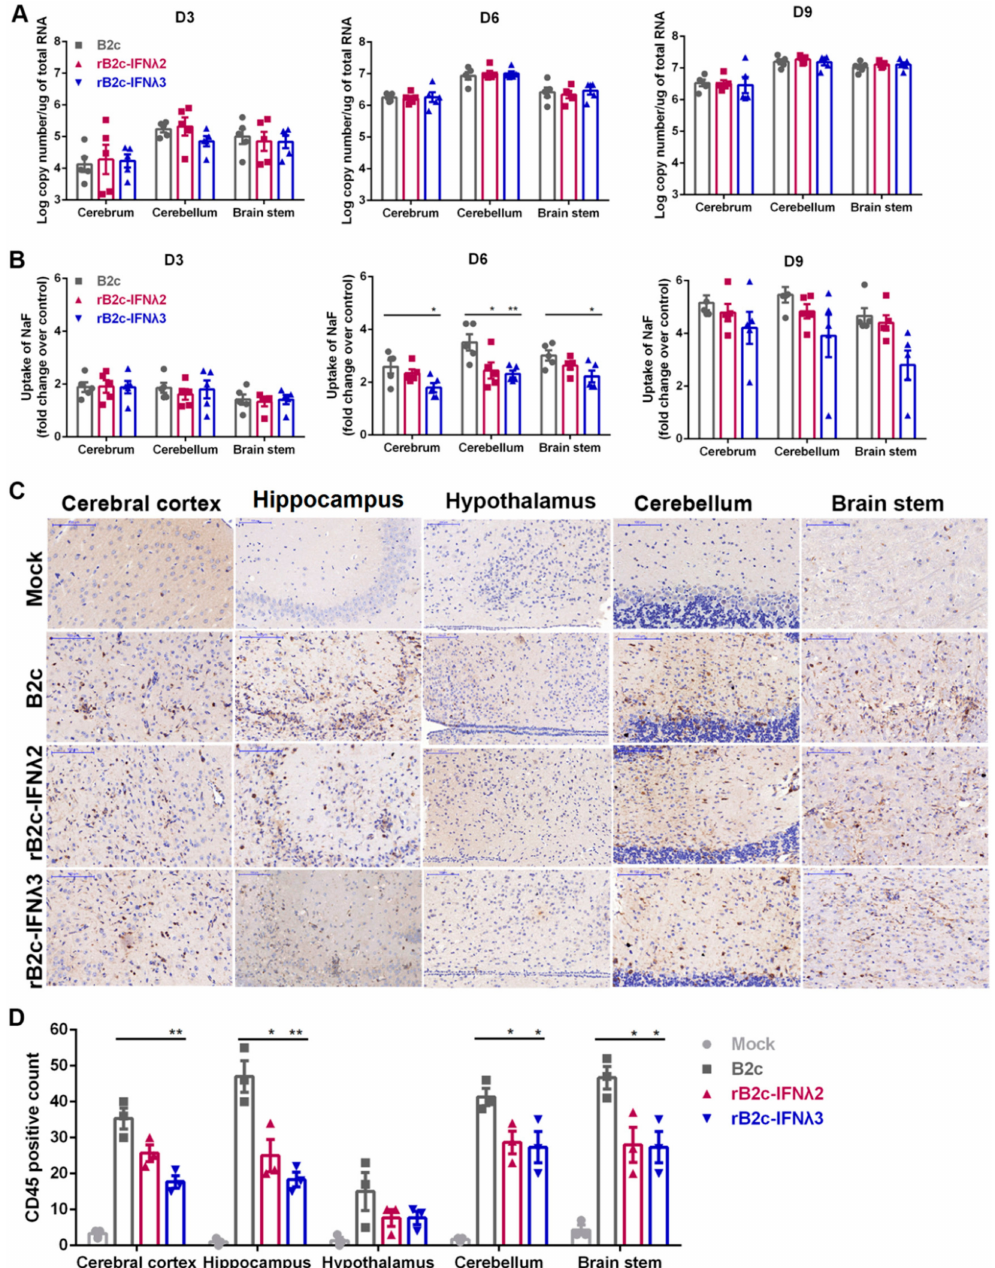
Figure 7. IFN- λ decreases BBB permeability and alleviates neurologic inflammation in the mouse brain. Six-week-old female BALB / c mice were inoculated i.c. with 100 FFU of rB2c, rB2c-IFN λ 2, rB2c-IFN λ 3, or DMEM (mock). ( A ) At 3, 6, and 9 dpi, mice ( n = 5) were euthanized, and the brains were harvested, and viral loads were determined by qRT-PCR. ( B ) The change in BBB permeability was assessed by measuring the amount of sodium fluorescein uptake in the cerebrum, cerebellum and brain stem using a spectrophotometer after intraperitoneal administration at 3, 6, and 9 dpi ( n = 5). ( C ) For the assessment of neurologic inflammation, six-week-old female BALB / c mice were inoculated i.c. with 100 FFU of B2c, rB2c-IFN λ 2, rB2c-IFN λ 3, or DMEM (mock). At 6 dpi, mice brains were collected and embedded in para ffi n. The sections were then stained with anti-CD45 antibody to quantify inflammation. The scale bars represent 100 µ m ( n = 3). ( D ) CD45 + lymphocytes from at least three di ff erent randomly selected areas of each brain region were counted. Error bars represent the SE. The following notations were used to indicate significant di ff erences between groups: *, p < 0.05; **, p <